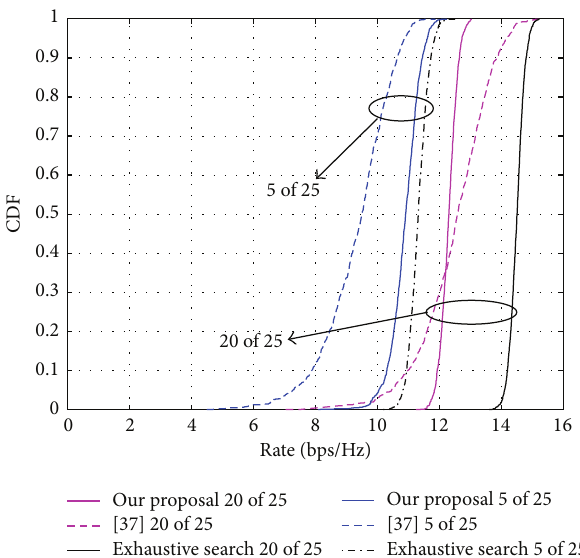
Figure 8: Comparison of CDF versus achievable rates of our proposal with [37] when 𝑀 𝑡 = 100 .